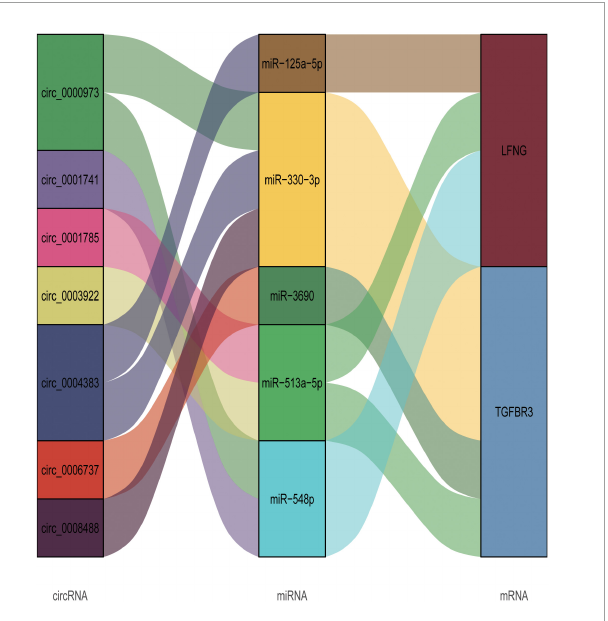
FIGURE4 circRNA-microRNA-mRNA related ceRNA regulatory network. In this figure, the first column represents the differentially expressed exosomal circRNAs from patients with CHD, the third column depicts the mRNAs from patients with acute myocardial infarction with differentially expressed mRNAs, and the second column denotes the microRNAs with intersection with circRNA and mRNA as predicted by bioinformatic